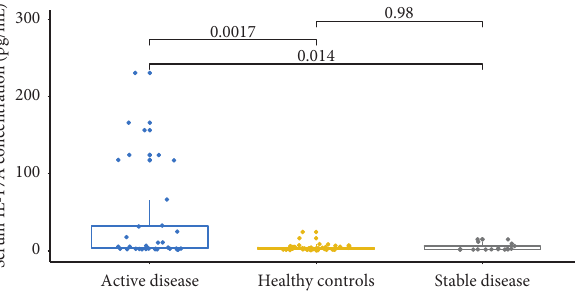
Figure 1: Serum levels of IL-17A in active and stable disease and healthy